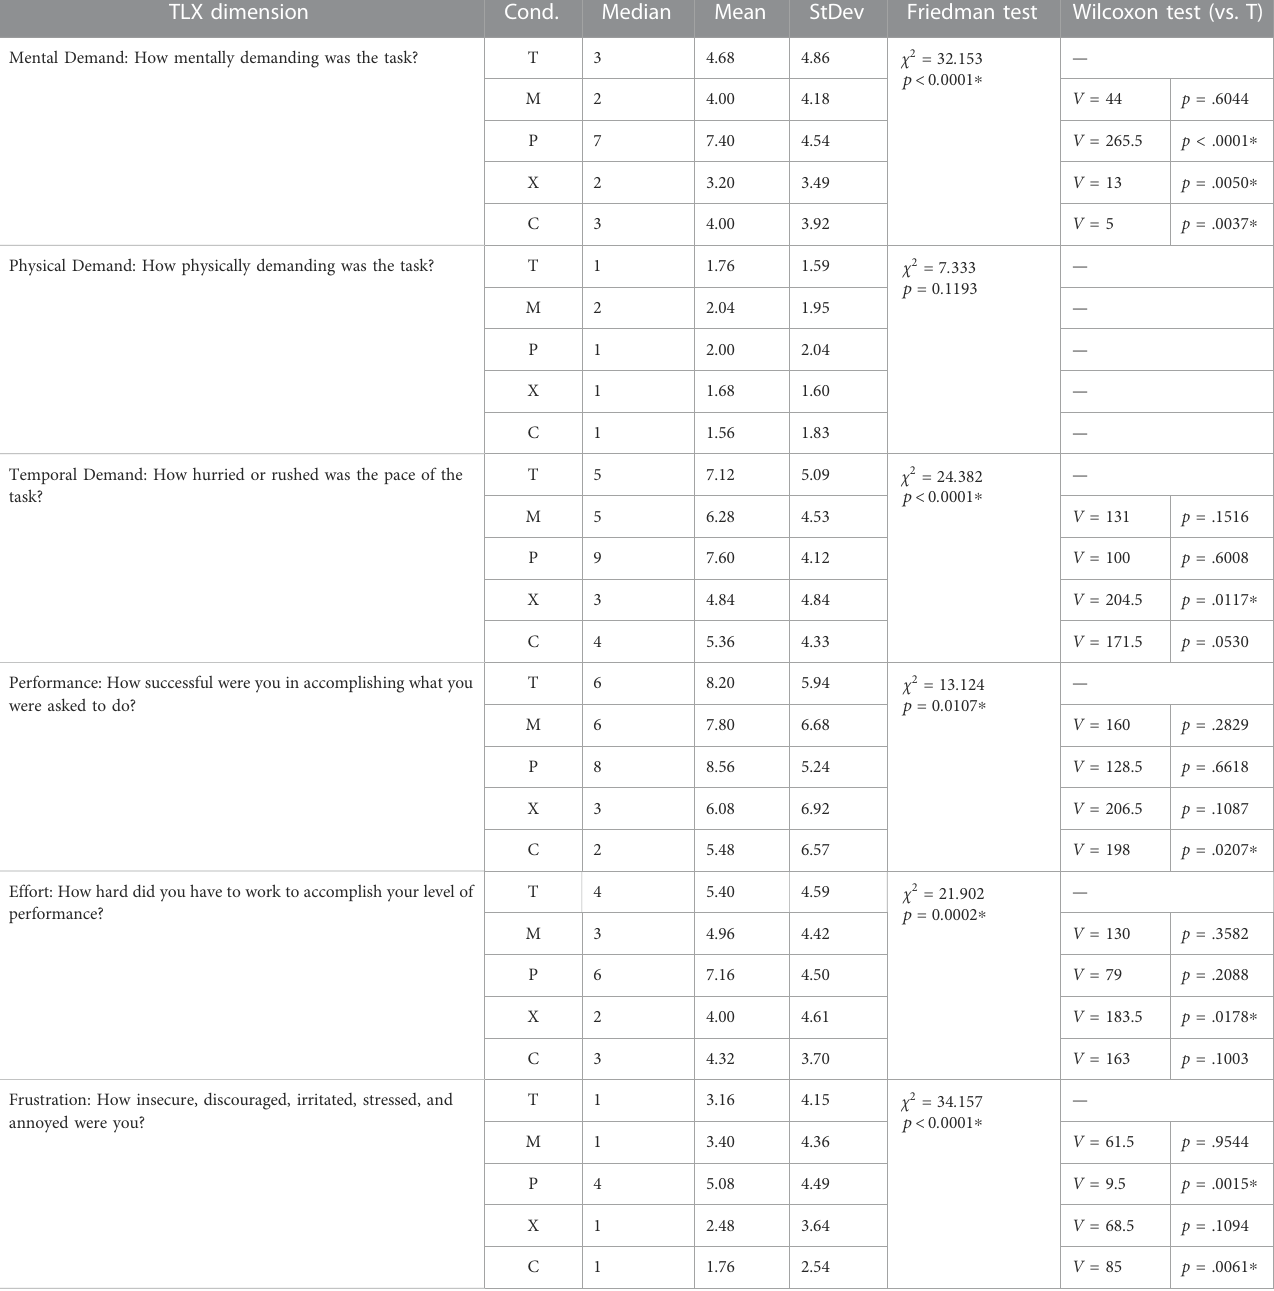
TABLE 4 Statistical test result of NASA TLX. Asterisks (*) indicate statistical signi fi cance. TLX dimension Cond. Median Mean StDev Friedman test Wilcoxon test (vs.